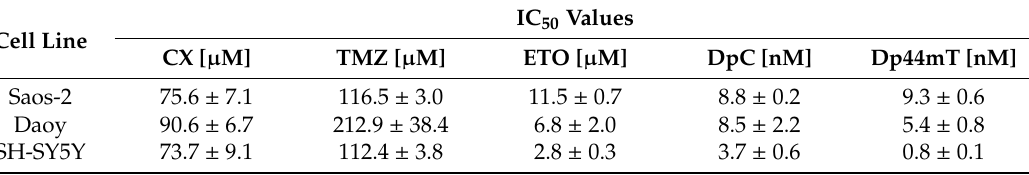
Table 1. IC 50 values. The IC 50 values of the individual drugs were determined in each cell-type after incubation with each drug alone for 72 h / 37 ◦ C. The results are presented as the mean ± SD (3